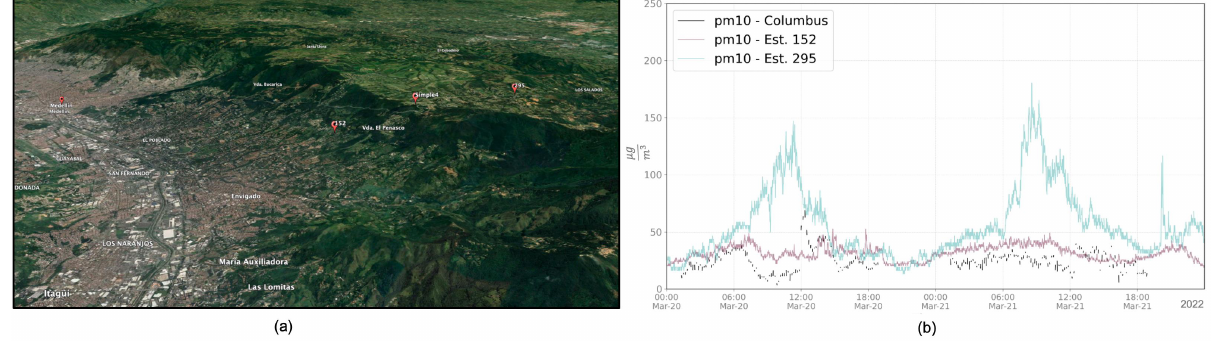
Figure 12. ( a ) Locations of a Simple 4 compared with two sensors of the Ciudadanos network at two altitudes. ( b ) PM10 concentrations. Interesting to see how the mountains can “contain” the contamination; it is clear these days that the concentration is greater within the valley and, on the other side, also greater than that recorded by the device. At the altitude of the module in the Columbus, that more wooded corridor of the slopes of the eastern mountains of the Aburrá Valley can also be